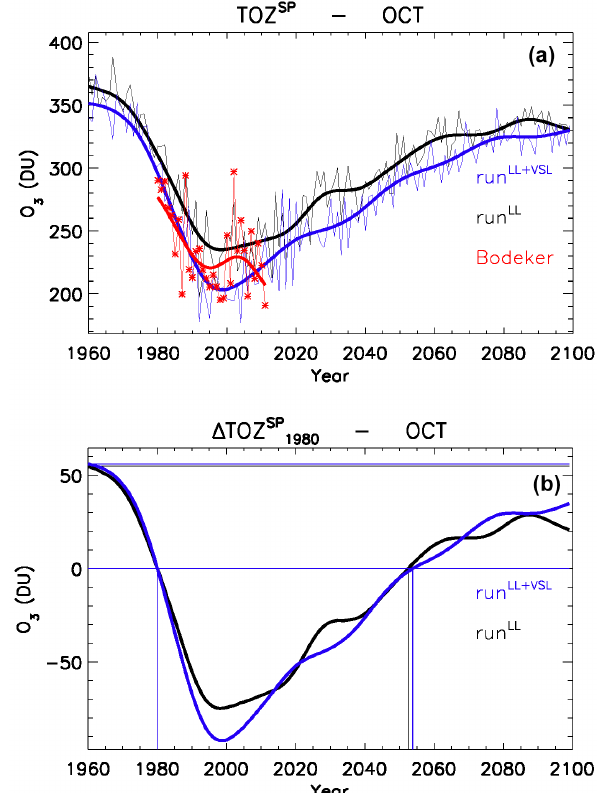
Figure 2. Temporal evolution of the total ozone column averaged within the southern polar cap (TOZ SP ) during October. CAM-Chem results are shown in blue for run LL + VSL and black for run LL . (a) Absolute TOZ SP values for the ensemble mean (thin lines) and the 11-year smooth time series (thick lines). Red lines and sym- bols show merged satellite and ground base measurements from the Bodeker database averaged within the same spatial and tem- poral mask as the model output. (b) Total ozone column adjusted = TOZ SP − TOZ SP ) . with respect to October 1980 ( (cid:49) TOZ SP year 1980 1980 The zero horizontal line indicates the October (cid:49) TOZ SP column 1980 for each experiment, while their respective return dates to 1980 are shown by the vertical lines. The upper horizontal lines represent the TOZ SP column during October 1960 for run LL + VSL and run LL . Equivalent figures for each independent simulation are shown in the